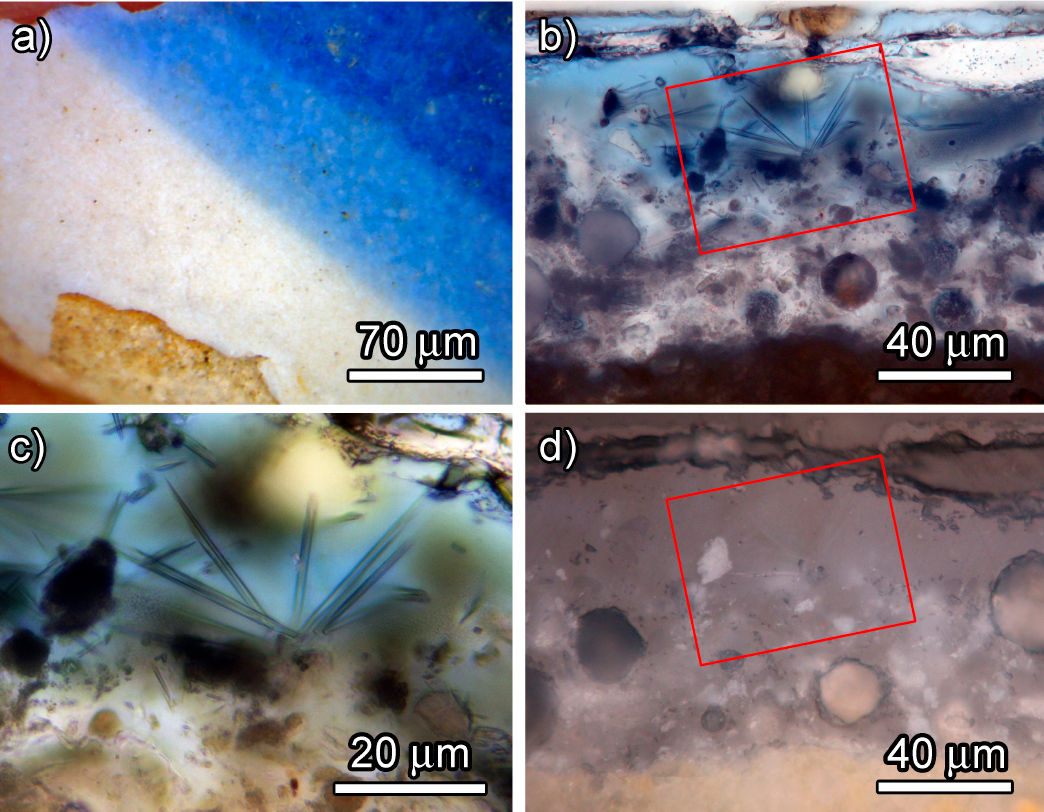
Figure 1. ( a ) An optical image of the glaze decoration taken with a digital microscope: A white and a blue glaze layer can be observed. ( b ) A photomicrograph of the glaze and its decoration (TL): The decoration is made up by a transparent blue glaze over a less transparent (white) glaze. In the interface between both glazes, some acicular neo-formed crystallites can be seen (indicated with a red rectangle). ( c ) A photomicrograph of the decoration (TL): Detail of the acicular crystallites is arranged as radial aggregates. ( d ) The same area as in Figure 1b (RL): The radial aggregates of the crystallites are not visible on the polished surface.